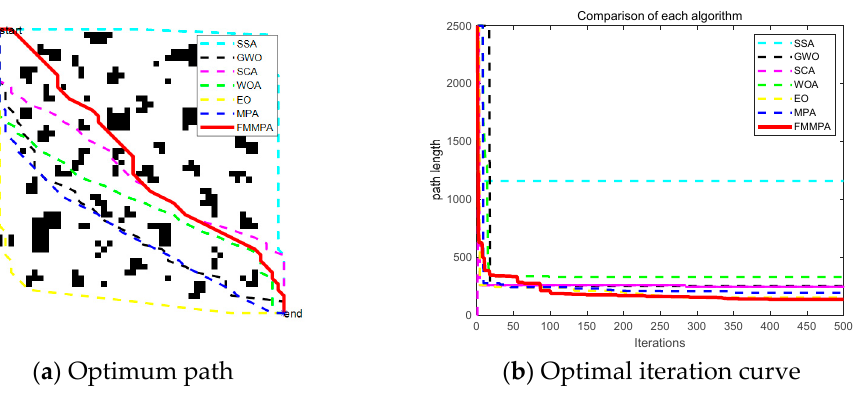
Figure 9. Experimental results for map 3.